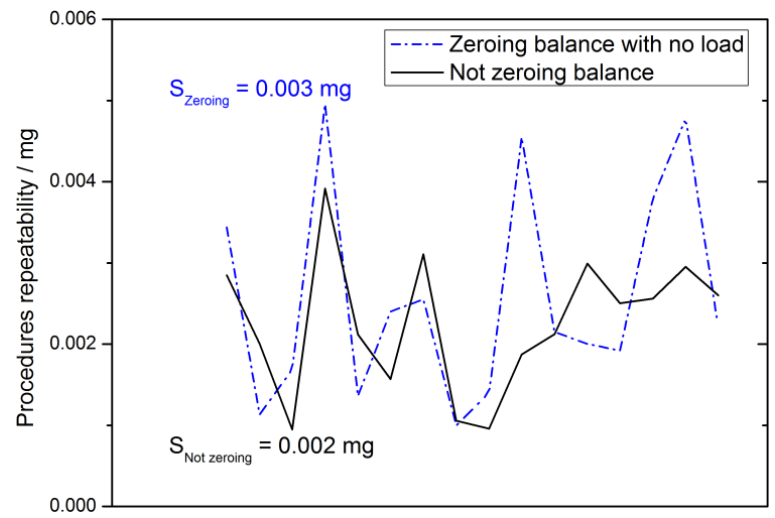
Figure 14. Repeatability values obtained from each drift elimination procedure.